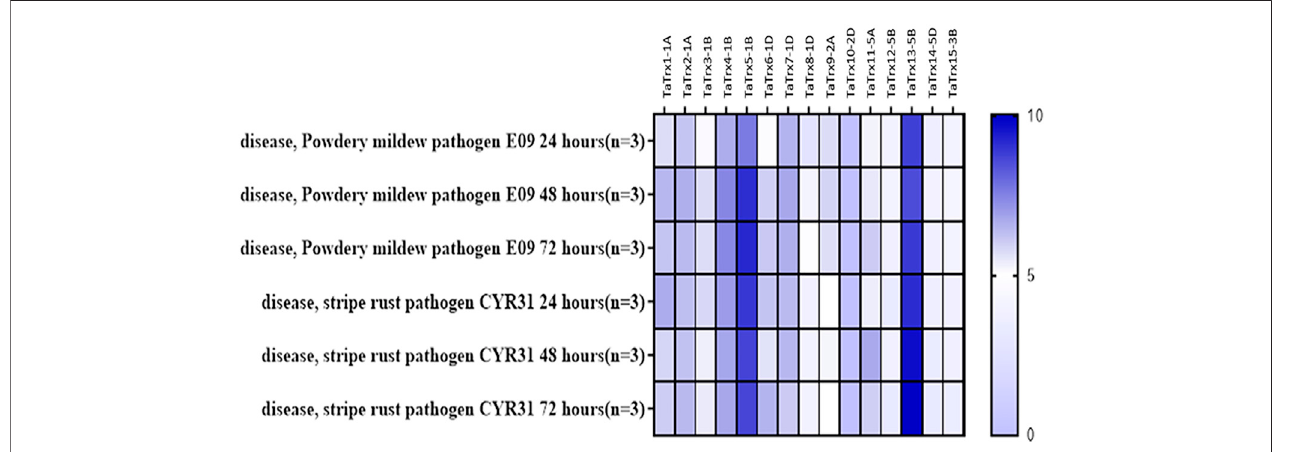
FIGURE 1 | In silico expression analysis of TaTrx genes against biotic stresses using expVIP (http://wheat-expression.com/).